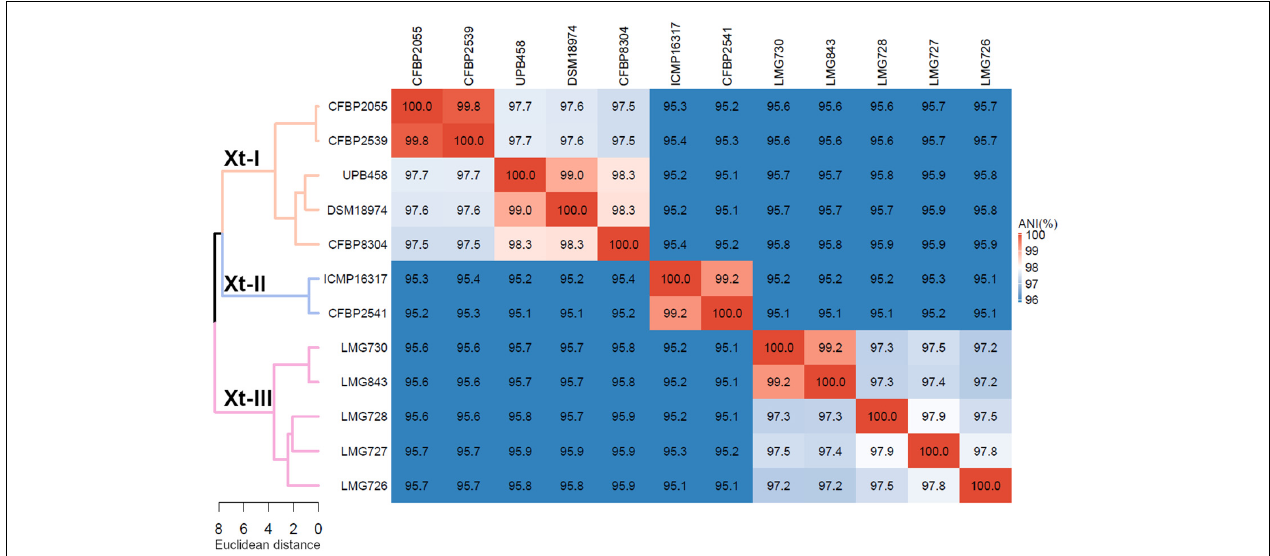
FIGURE 1 | Average nucleotide identity (ANI) of X. translucens pathotype strains and ANI-based phylogeny constructed with Ward’s hierarchical clustering method. Distance in the dendrogram represents ANI dissimilarity between nodes. Orange: clade Xt-I, blue: clade Xt-II, pink: clade Xt-III. ANI is depicted as a gradient from blue ( < 96%) to white (98%) to red